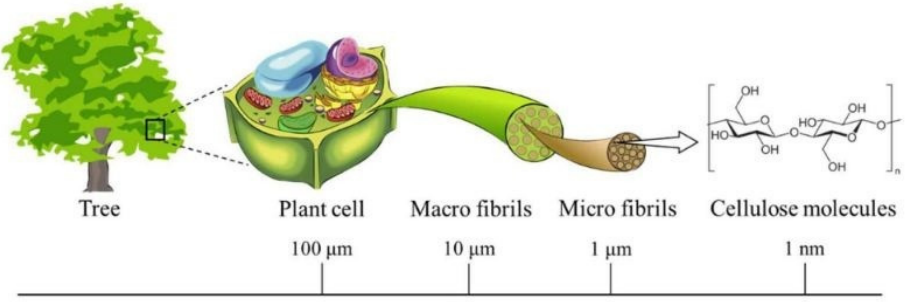
Figure 6. Cellulose contained in plants has a hierarchical structure from the meter to nanometer scale (reprinted with permission of authors from reference [67]).